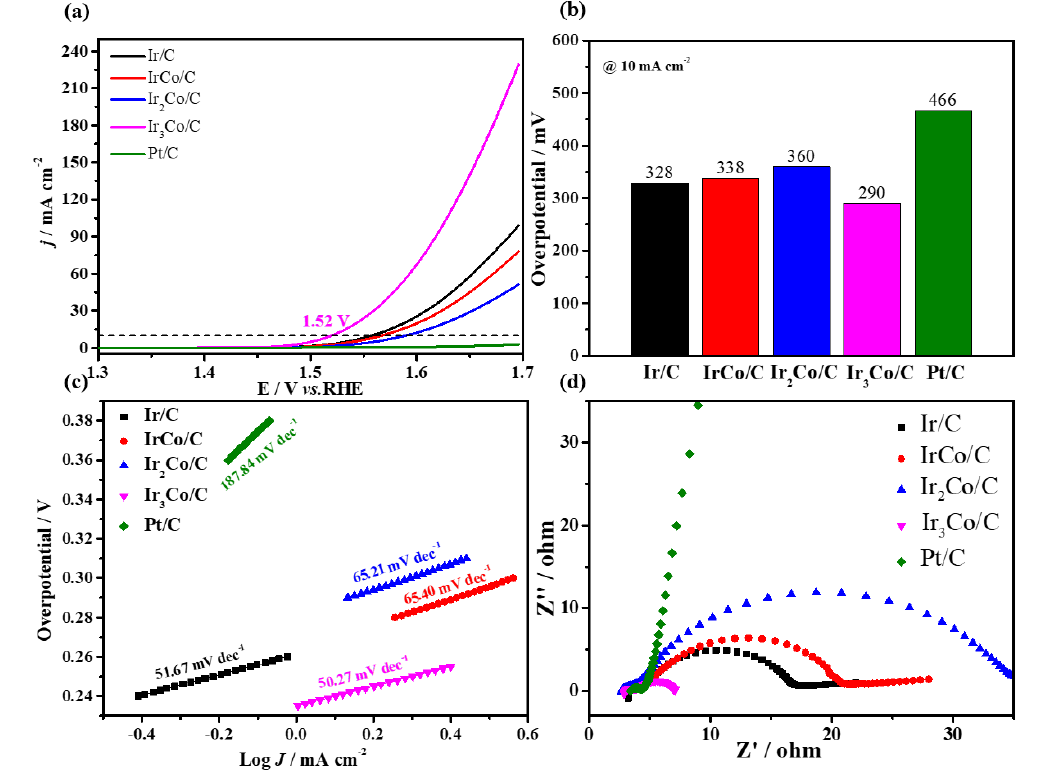
Figure 2. Electrochemical test results of different catalysts. ( a ) Polarization curves of OER in 0.5 M H 2 SO 4 . ( b ) The overpotential required to reach 10 mA cm −2 . ( c ) The corresponding Tafel slopes. ( d ) EIS.